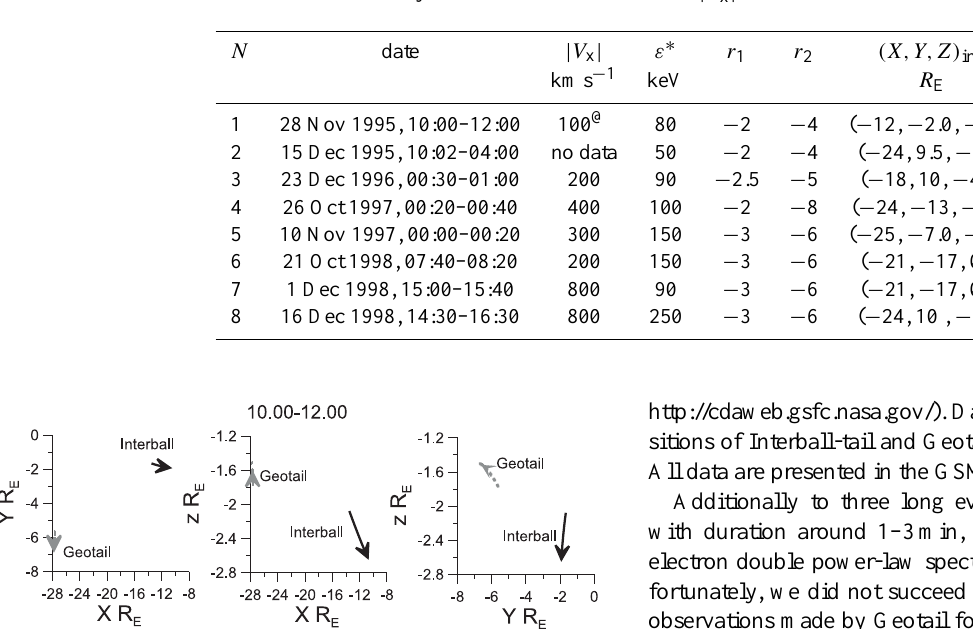
Table 1. List of events. For the event marked by @ Geotail observations show | V x | ∼ 300kms − 1 .